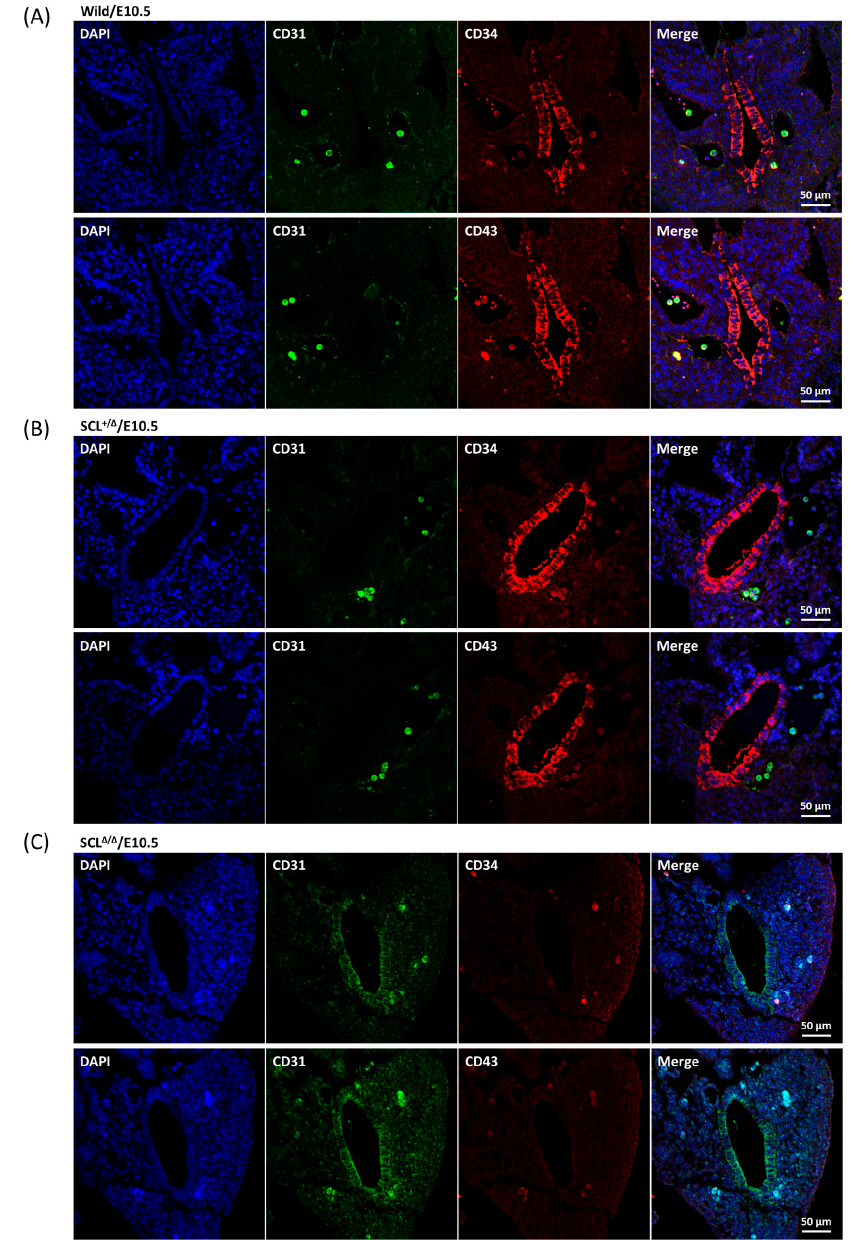
Figure 5. Expression patterns of CD31 and CD34 in E10.5 wild-type and SCL deletion embryos. Transverse sections of E10.5 wild-type ( A ) and SCL +/ ∆ ( B ), and SCL ∆ / ∆ ( C ) embryo proper were co-stained with either CD31 and CD34 (upper panels) or CD31 and CD43 (lower panels). A layer of the CD31 − /CD34 + and/or CD31 − /CD43 + cells emerged on the endothelial layer of the aorta of the wild-type and the heterologous Scl +/ ∆ E10.5 embryos, meanwhile several CD31 + /CD34 + and/or CD31 + /CD43 + cells are observed in the other lumens of these sections ( A , B ). On the other hand, a layer of CD31 + cells without CD34 or CD43 signals was shown in the E10.5 SCL ∆ / ∆ sections ( C ). Regardless of the genotypes, a few CD31 + /CD34 + and/or CD31 + /CD43 + cells were stained in the other cavities beyond the aorta ( A – C